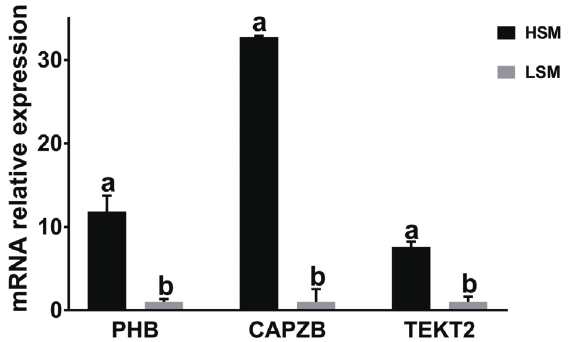
Figure 5. PHB (a), CAPZB (b), and TEKT2 (c) mRNA expression in the sperm samples with high and low motility. “HSM” represents the sperm sample with high motility while. “LSM” represents the sperm sample with low motility. PHB, prohibitin; CAPZB, capping actin protein of muscle Z-line beta subunit; TEKT2, tektin-2. Data represent mean±standard deviation of three replicates, and the different superscripts in the same table indicate significant difference